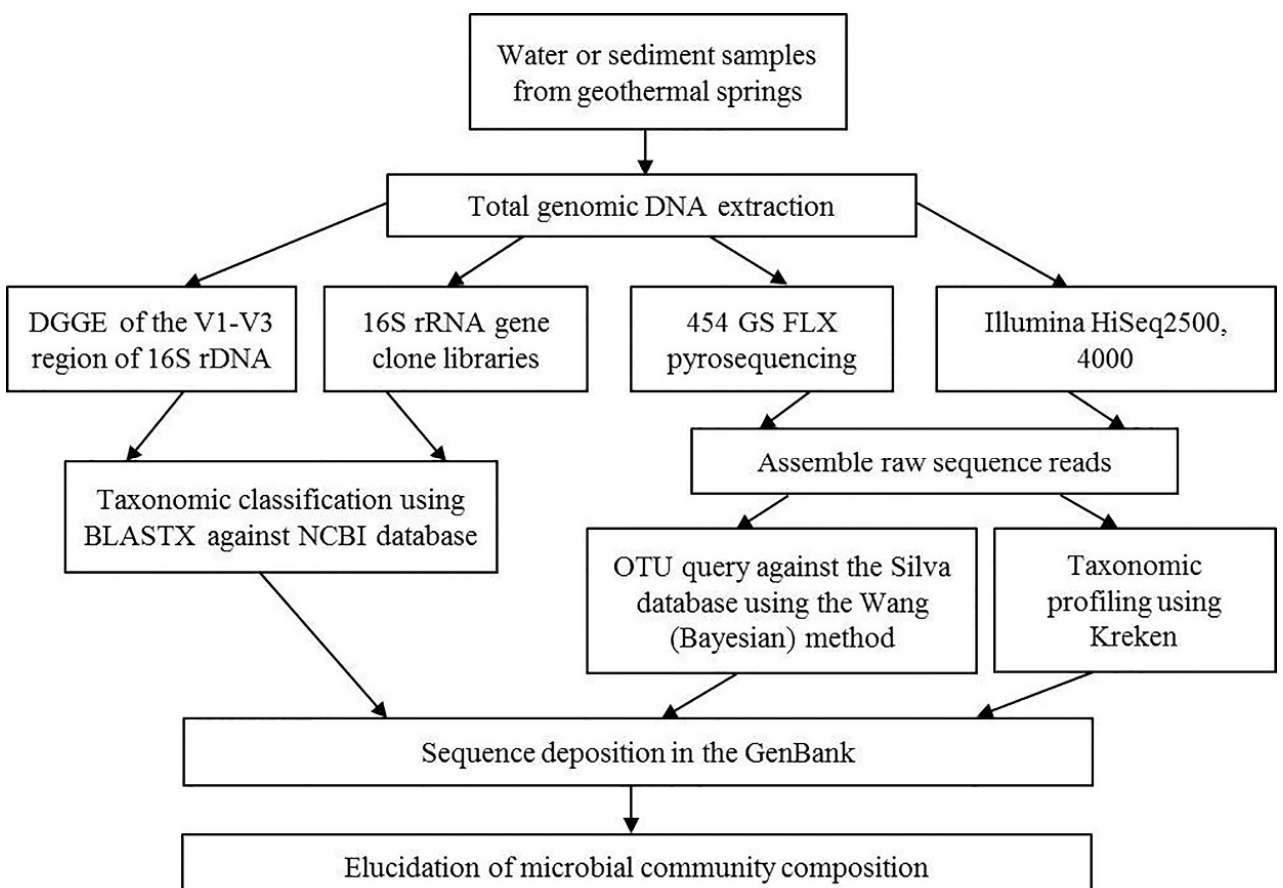
Figure 2. Culture-independent analysis workflow.